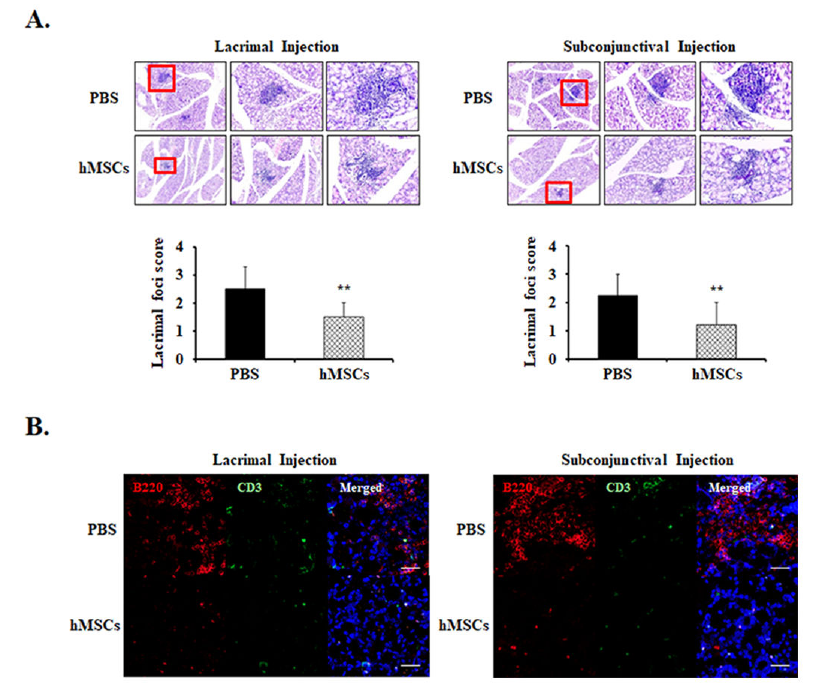
Figure 2. Representative lacrimal gland histology for PBS-treated or hMSCs-treated mice. ( A ) Lacrimal gland histological sections obtained from 19-week-old NOD/ShiLtJ mice stained with H&E. Extraorbital lacrimal glands were removed and fixed in formalin then serially sectioned and stained. The representative photomicrographs demonstrate the leukocyte infiltrations of the lacrimal glands and their pertaining lacrimal gland foci score. ( B ) The effects of hMSCs on B-cell and T-cell markers were shown with representative photomicrographs stained with B220 and CD3, respectively. Scale bar: 1000 µ m. Data are presented from six independent experiments ( n = 6). ** p <